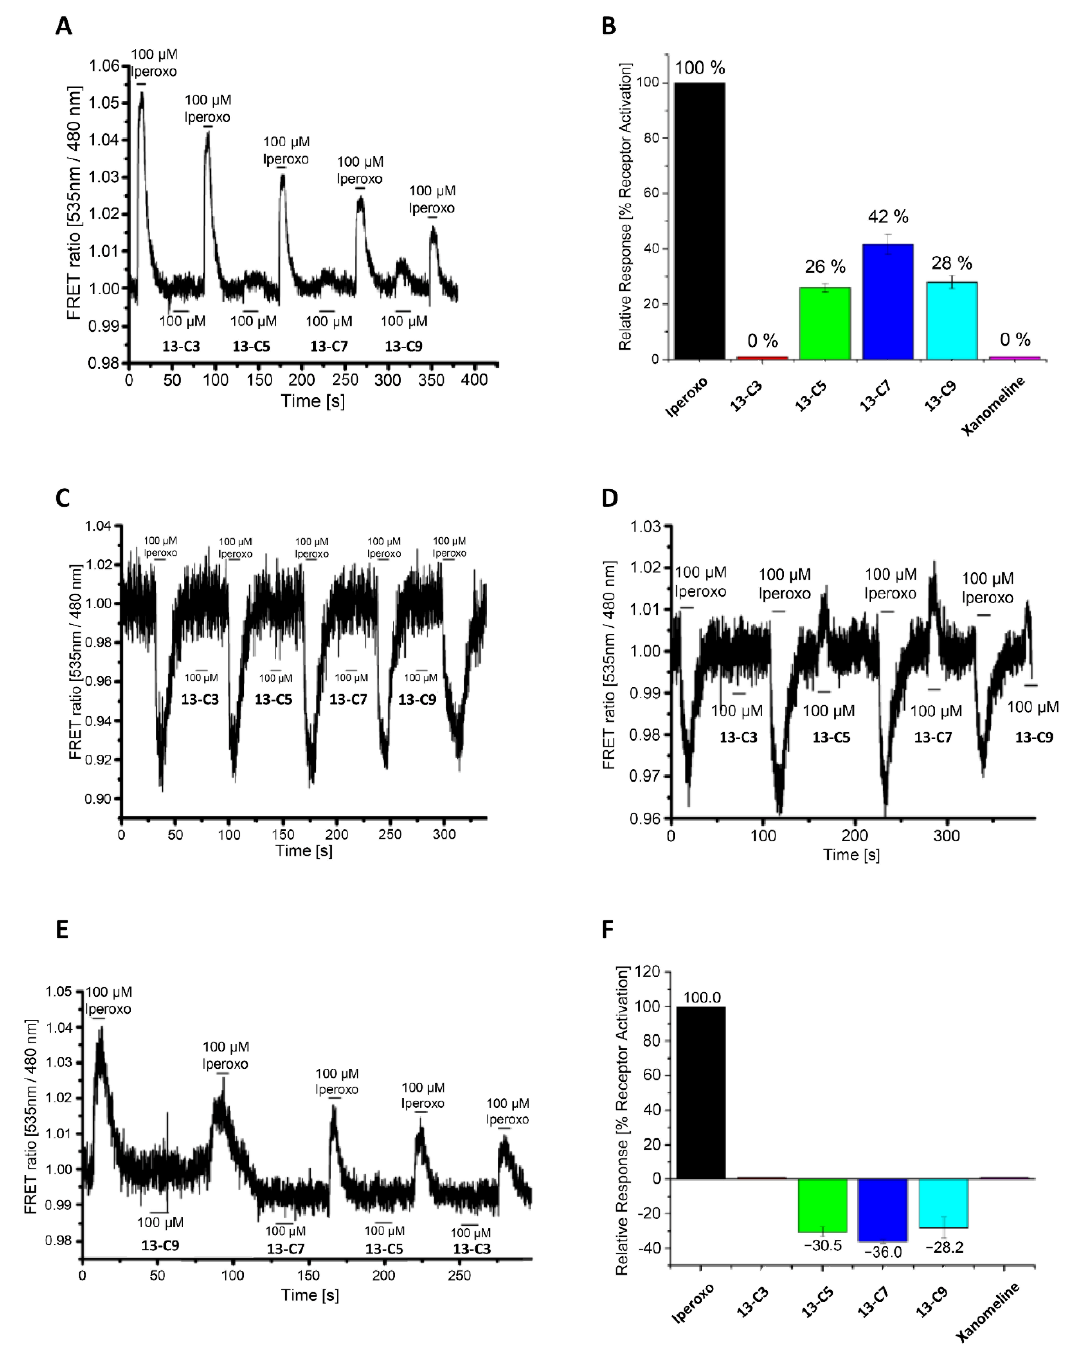
Figure 5. Evaluation of the Xanomeline/77-LH-28-1 hybrid ligands 13-Cn at the M 1 ( A ); M 2 ( C ); M 4 ( D ); and M 5 ( E ) muscarinic FRET receptor sensors stably expressed in HEK293 cells. One hundred micromolar Iperoxos ( 2 ) were used as a reference ligand throughout the recording, as indicated by black bars above the recorded signals. One hundred micromolar concentrations of the hybrid compounds 13-C3 , 13-C5 , 13-C7 , and 13-C9 were applied as indicated at the appropriate time points by black bars below the recorded signal. The quantified maximal ligand-induced FRET response of compounds 13-Cn as a percent of control (100 μM Iperoxo) at the M 1 ( B ) and M 4 ( F ) receptor sensors is shown. Each bar represents the average of at least 10 independent measurements.